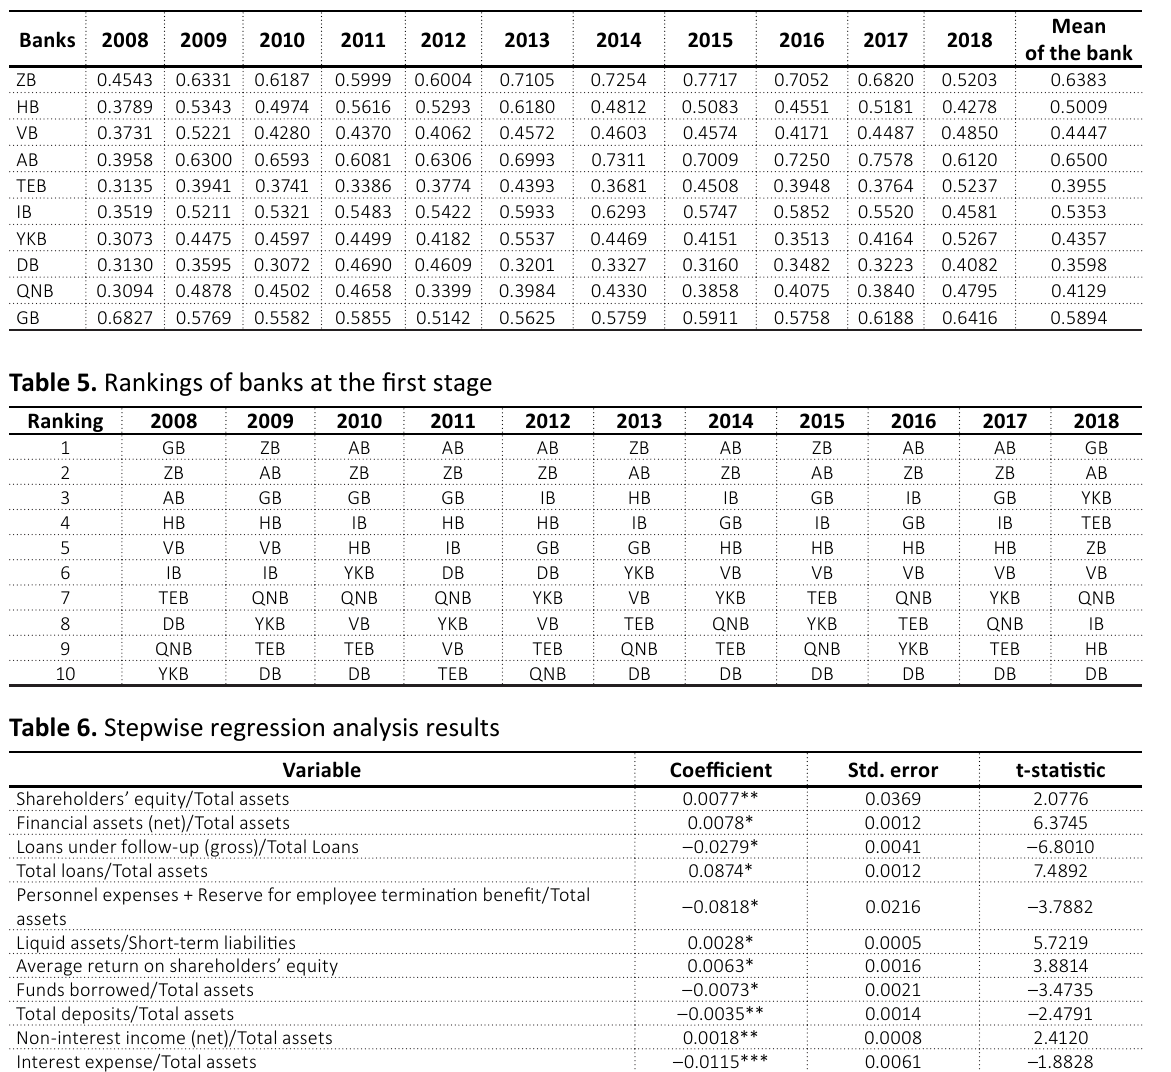
Table 4. Performance scores of the first stage